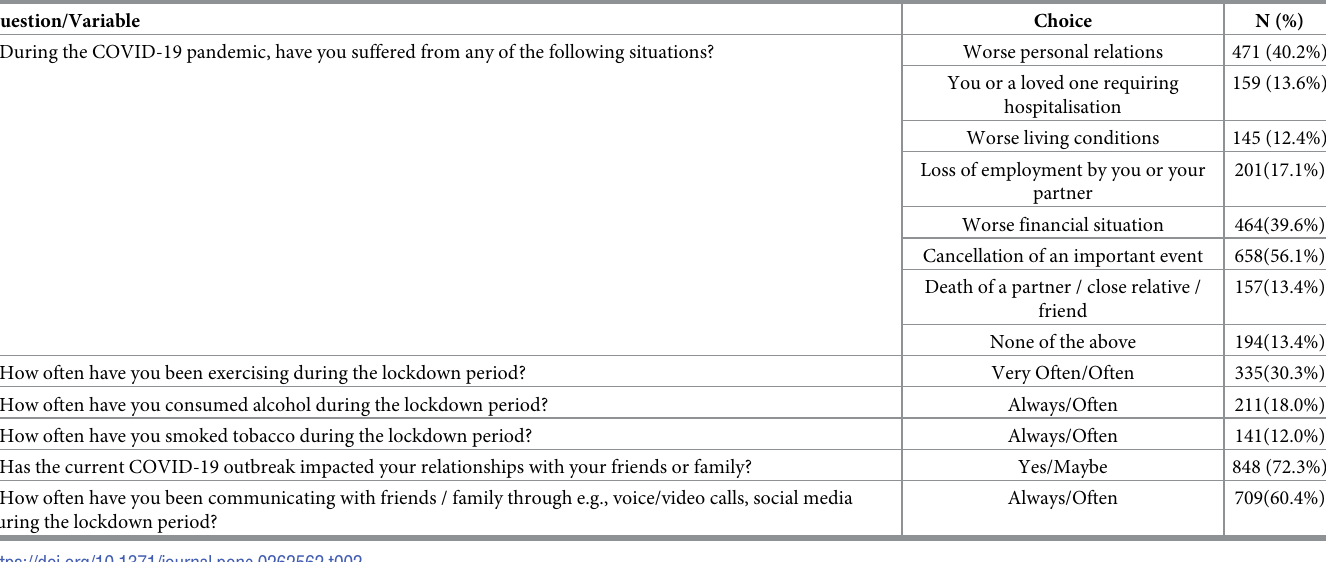
Table 2. Lifestyle / Living situation descriptive